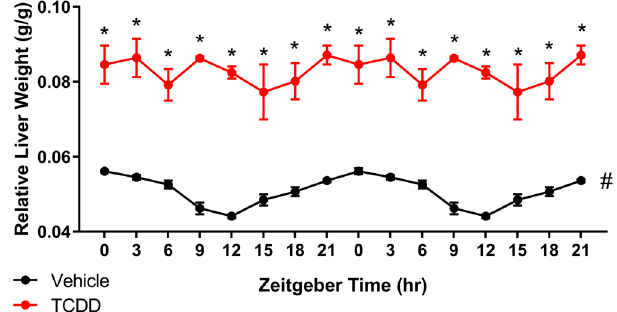
Figure 1. Relative liver weight (RLW) of male C57BL/6 mice orally gavaged with sesame oil vehicle or 30 µ g/kg TCDD every 4 days for 28 days. Data points represent the average of at least 3 individual mice ± standard error of the mean. Statistical significance ( * p ≤ 0.05) between vehicle and TCDD was determined using a two- way ANOVA analysis followed by Sidak’s multiple comparison test. JTK_CYCLE determined RLW in control animals exhibited daily oscillations (# BH q ≤ 0.1), while RLW rhythmicity was not detected in TCDD-treated mice. Data are double-plotted along the x-axis for better visualization of